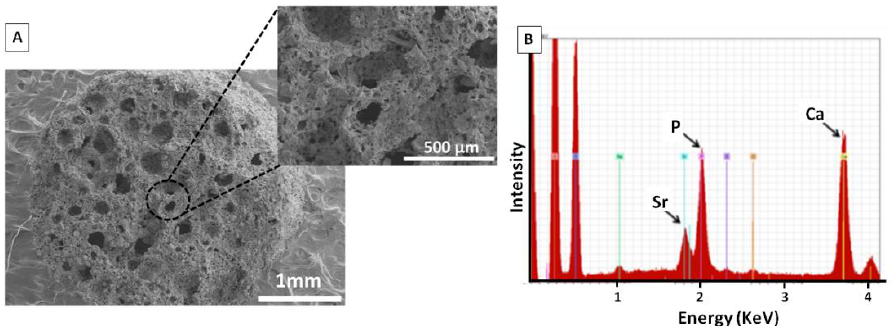
Figure 1. ( A ) SEM images of the porous support and ( B ) elemental surface analysis as determined by EDS.